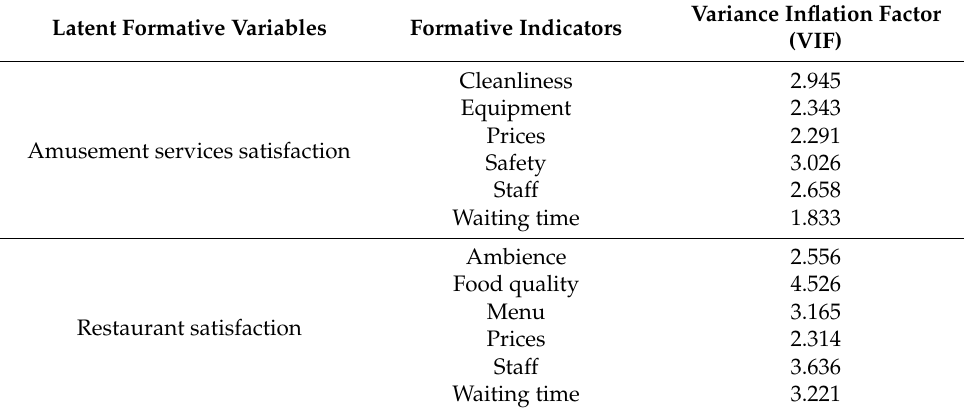
Table 3. Collinearity assessment among the formative